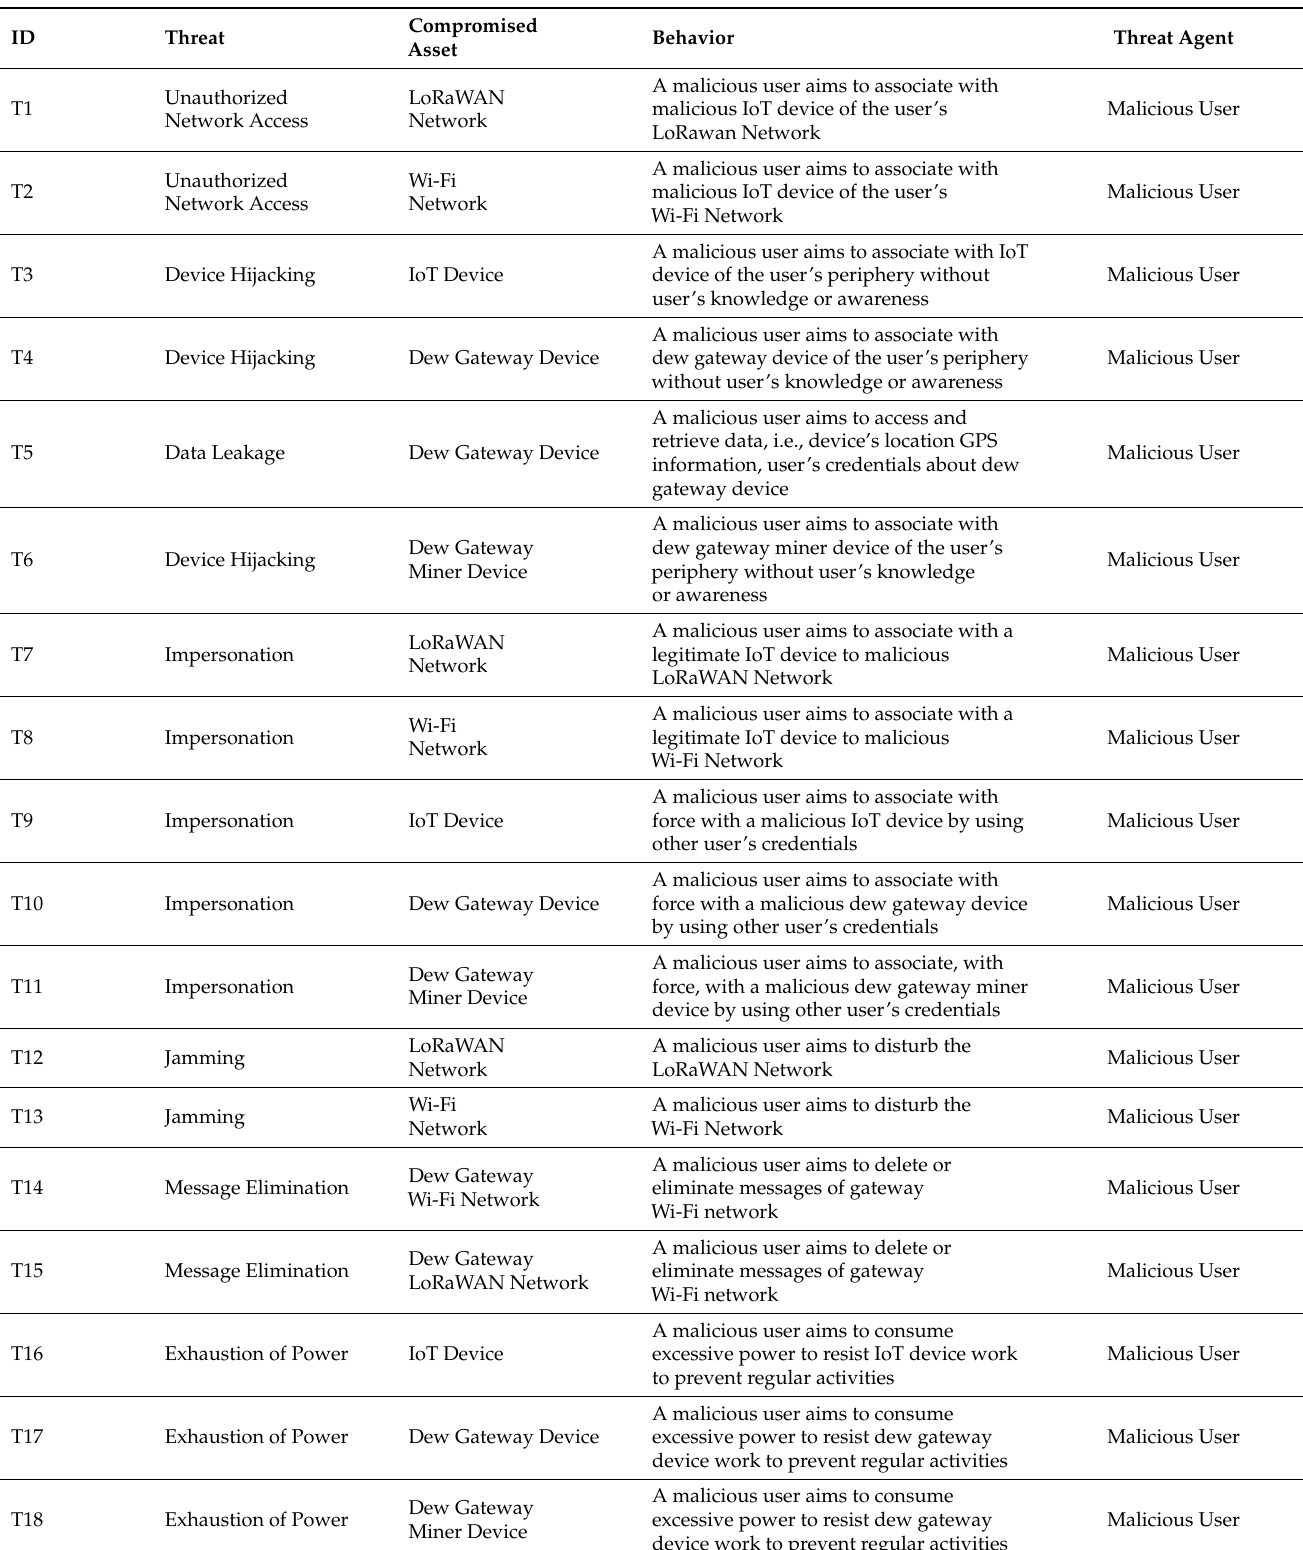
Table 2. Distributed Hotspot Network Threat